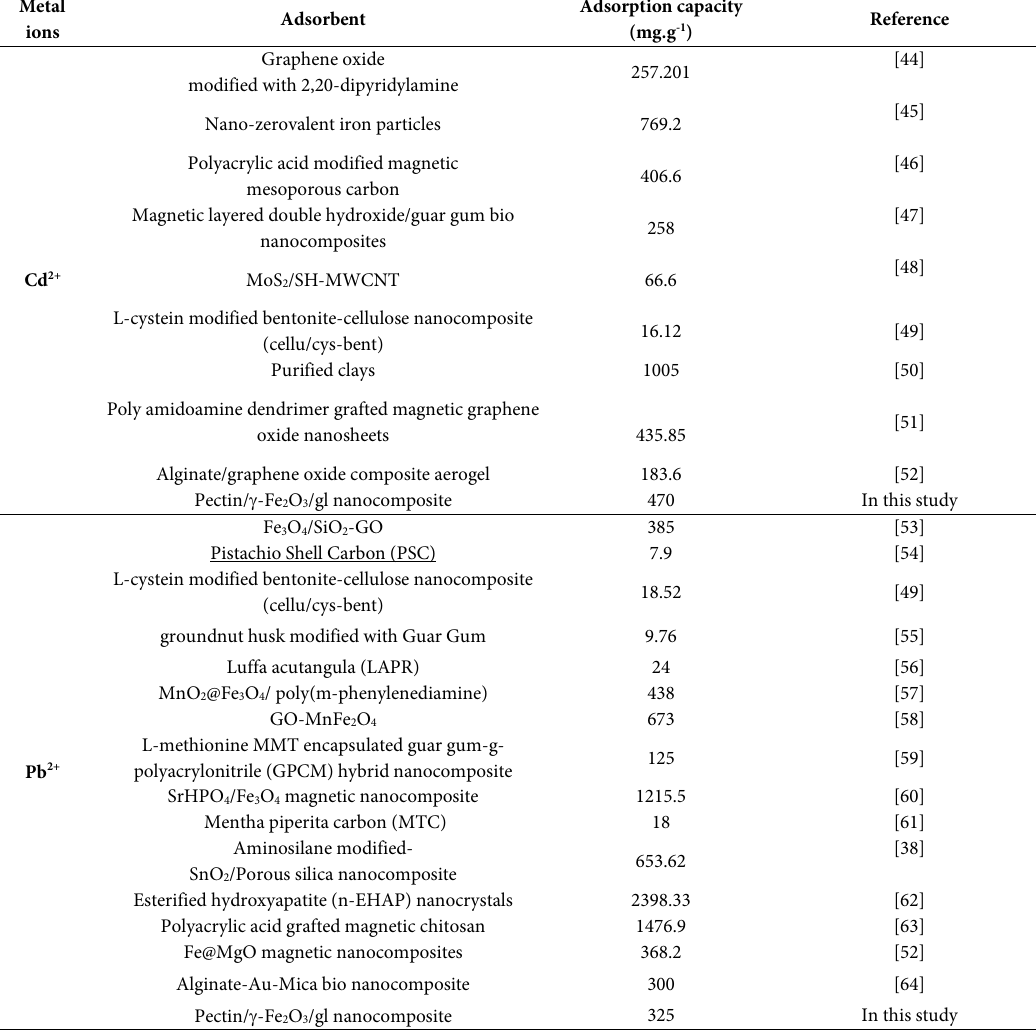
Table 5. Comparison of q values for Cd(II) and Pb(II) ions adsorption on different m